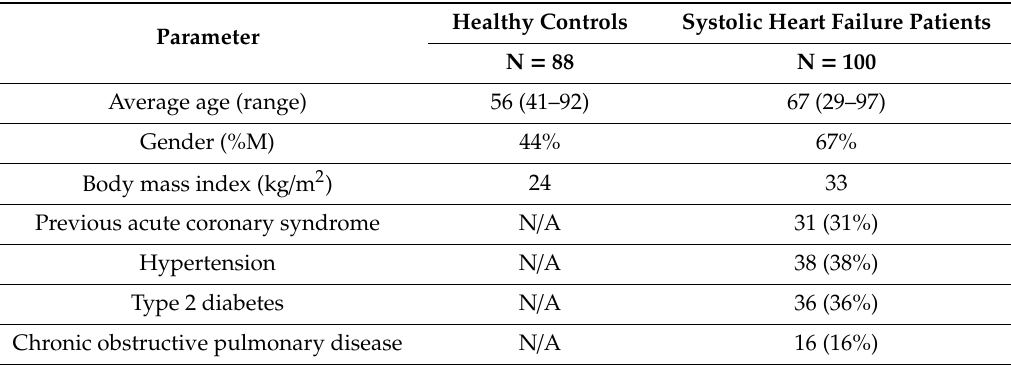
Table 1. Summary of relevant clinical characteristics for healthy controls and patients with systolic heart failure.